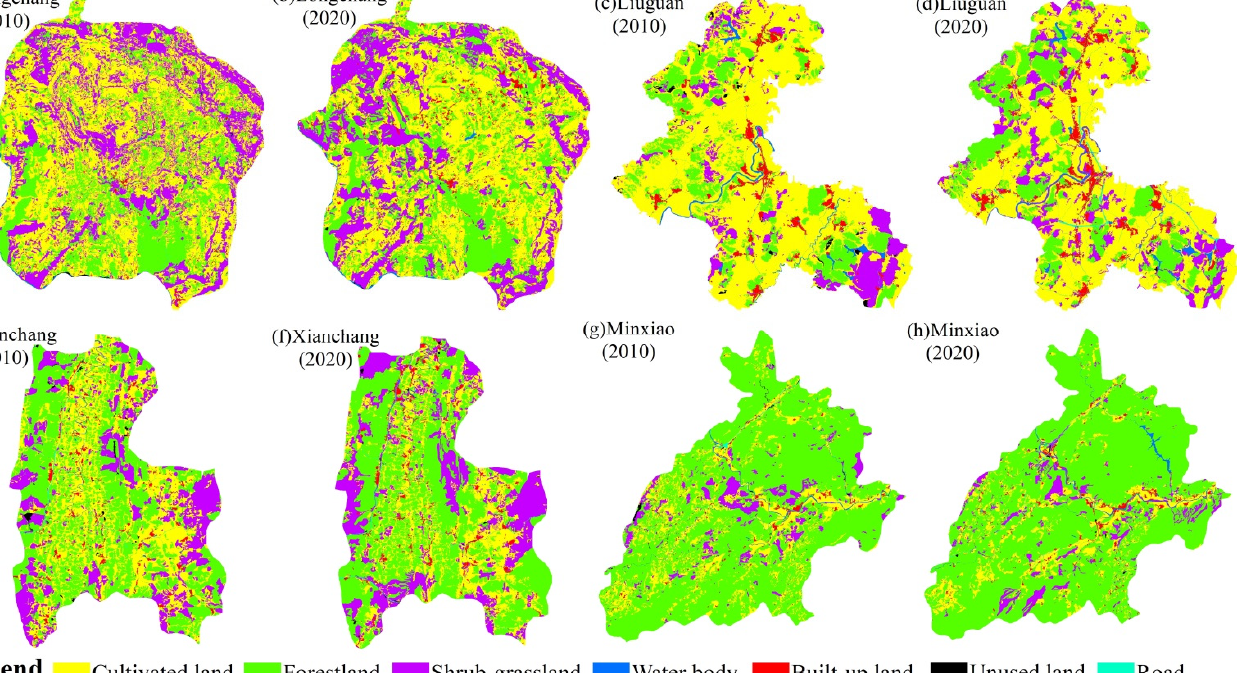
Figure 2. The distribution of land-use types. ( a ) Longchang in 2010,( b ) Longchang in 2020, ( c ) Liuguan in 2010, ( d ) Liuguan in 2020, ( e ) Xianchang in 2010, ( f ) Xianchang in 2020, ( g ) Minxiao in 2010, ( h ) Minxiao in 2020.